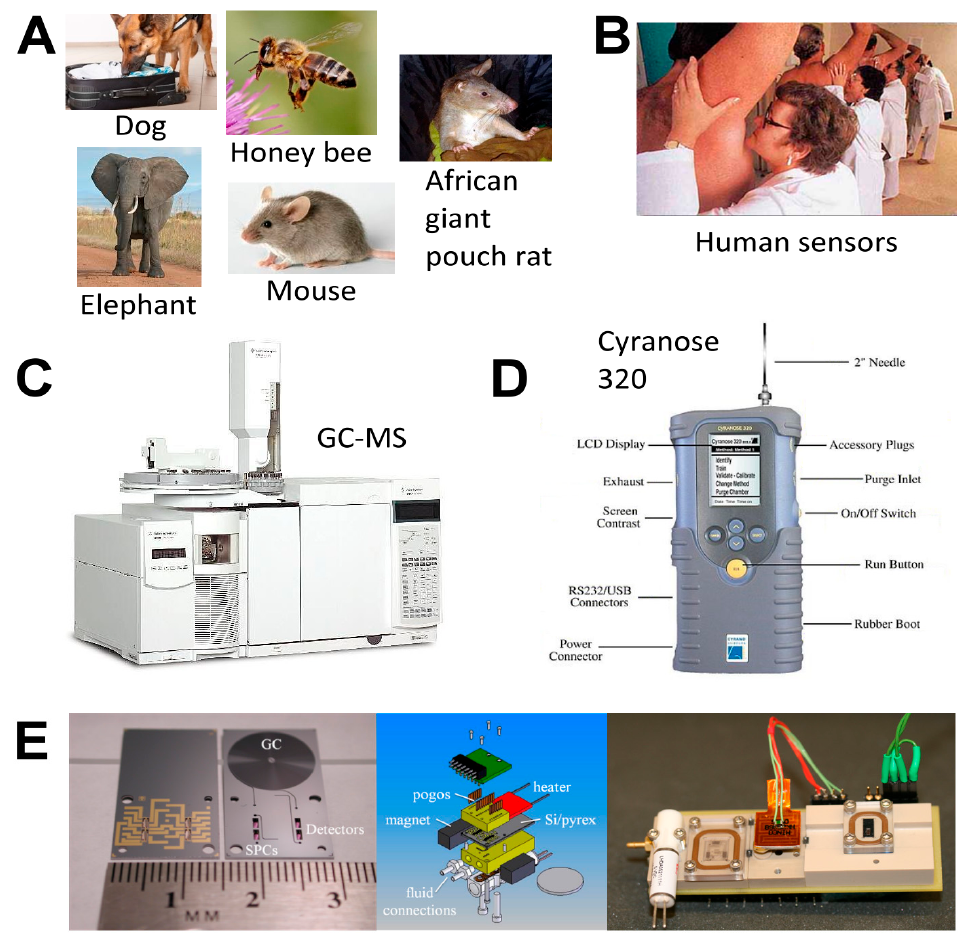
Figure 17. VOC detection. ( A ) Animal sensors; ( B ) Human sensors; ( C ) GC-MS; ( D ) e-Nose; ( E ) μ Systems.